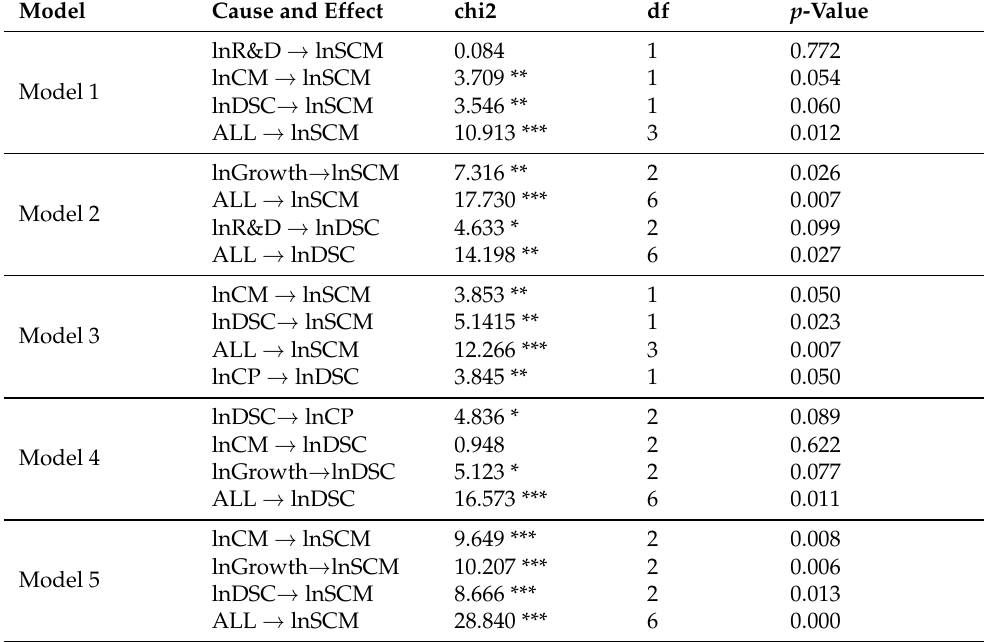
Table 4. Results of Granger causality